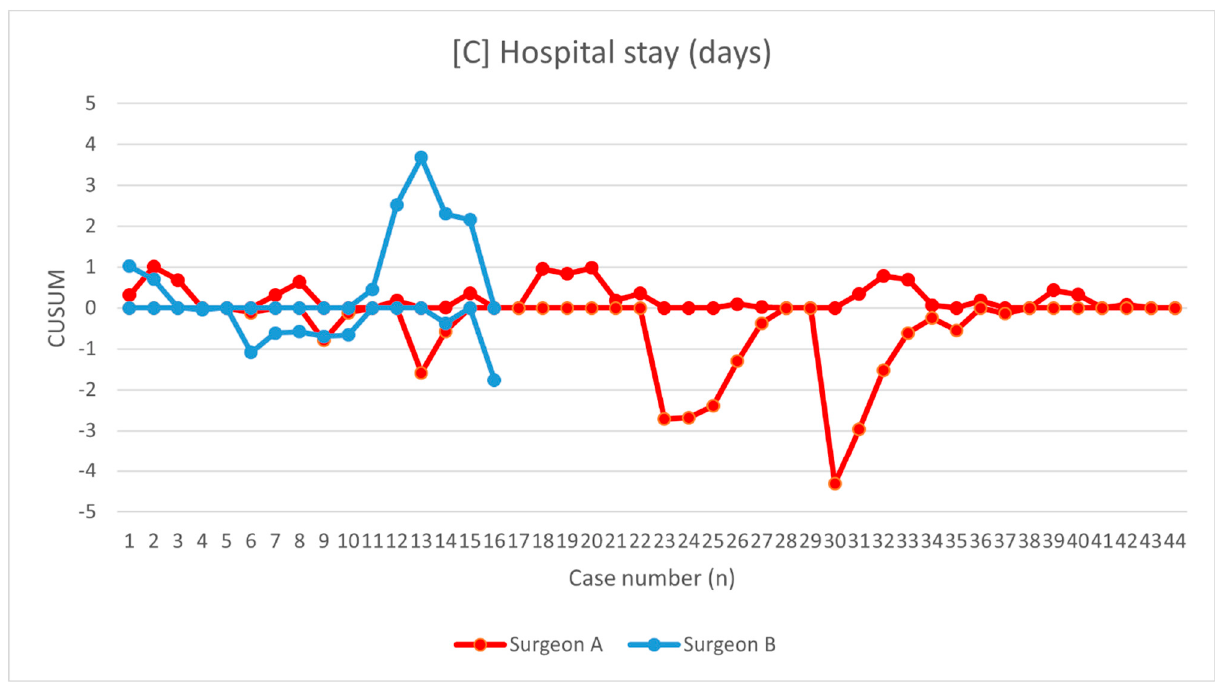
Figure 4. Chart showing the hospital stay presented as cumulative sum analysis separately for surgeons A and B.